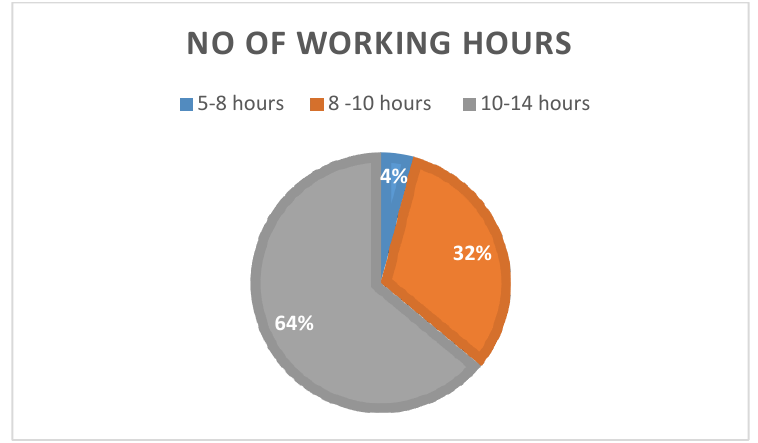
Figure 4. Working hours of waste pickers in Lagos, Nigeria. Source: Computed by authors.